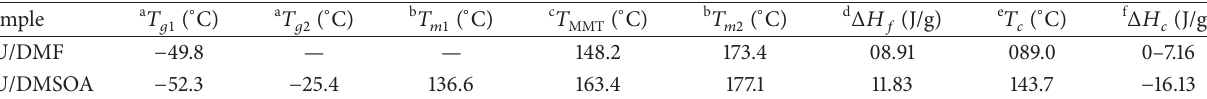
Table 1: DSC thermal data of polyurethane samples dissolved in different solvents.